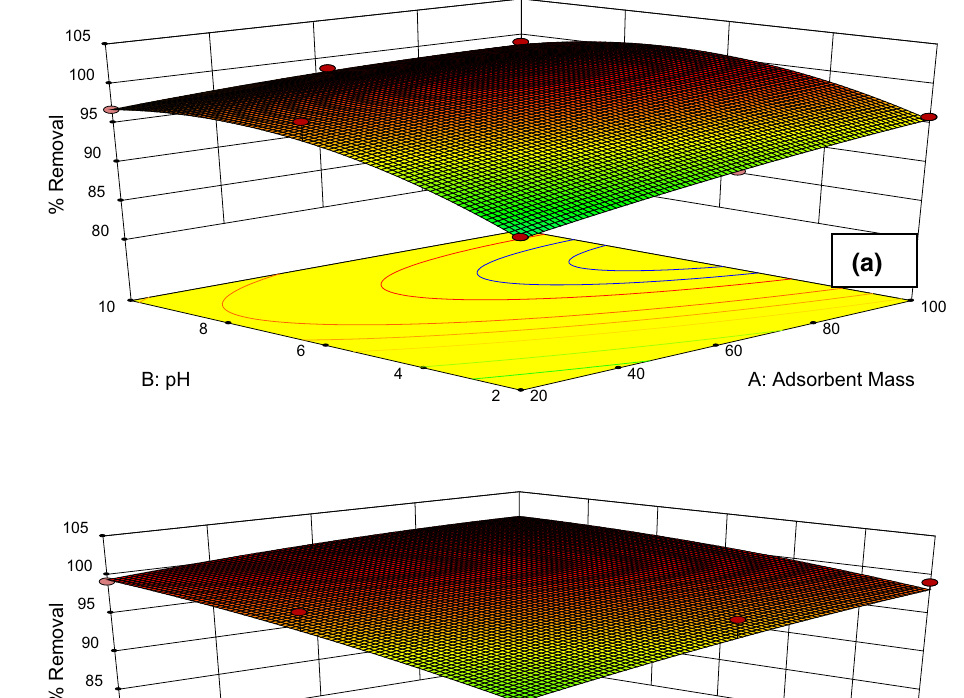
Fig. 14 Response surface plots of the effects of a pH vs adsor- bent dosage, b contact time vs adsorbent dose, c contact time vs pH for Pb(II) removal